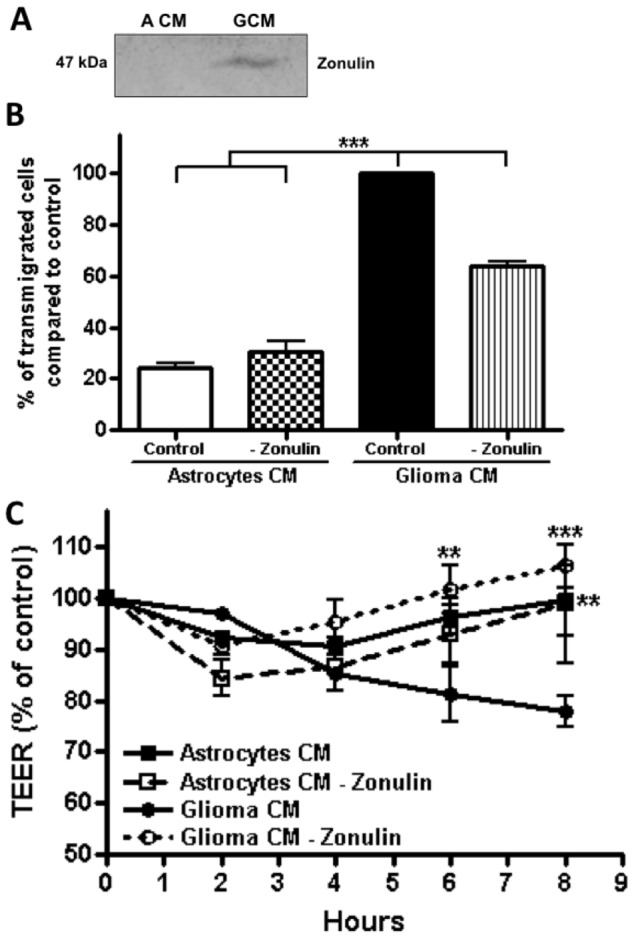
Zonulin present in glioma C6 CM, opens the BBB and favors ReNcells CX transmigration.A) Zonulin is detected by Western blot in glioma C6 CM and not in astrocyte CM. B) ReNcells CX
transmigration assay across RBMECs done by placing in the basal compartment of the Millicell,
astrocyte or glioma C6 CM with or without zonulin. N = 6, F(3,20) = 228.2; *** p<0.001; as
assessed by one-way ANOVA followed by Bonferroni's post hoc test. C) Elimination of zonulin from
glioma C6 CM reverses the decrease in TEER exerted by glioma C6 CM. N = 3, F(3,30) = 5.981;
**P<0.01, ***P<0.001 with respect to glioma C6 CM; as assessed by two-way ANOVA followed by
Bonferroni's post hoc test.